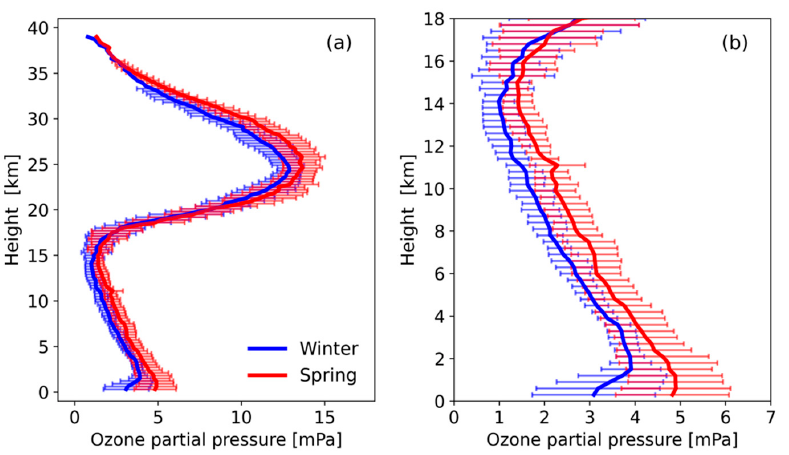
Figure 4. Profiles of ozone partial pressure at ( a ) the entire detection levels and ( b ) within the troposphere, averaged across the spring (red line) and winter (blue line). The error bars represent the standard deviation of the individual observations.